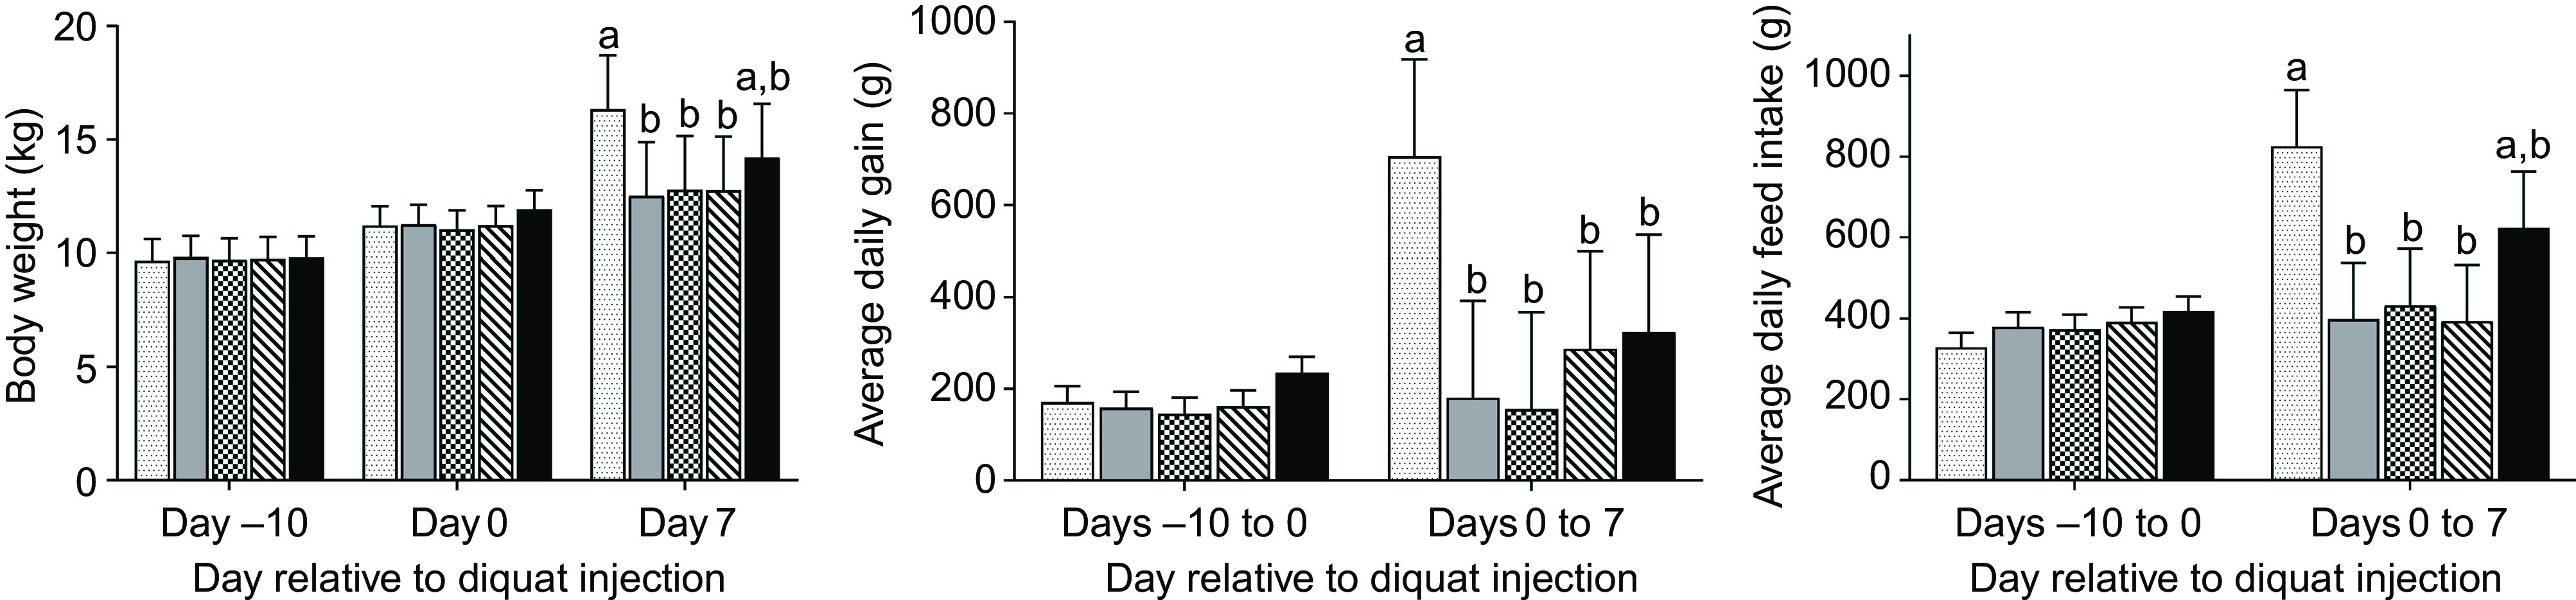
Growth performance and feed intake of piglets (n 7/treatment) in response to diquat challenge and dietary selenium supplementation. Values were presented as least square means with their standard errors. a,b Mean values with unlike letters were significantly different (P < 0·05). , Negative control without diquat challenge nor dietary selenium supplementation; , positive control with diquat challenge without dietary selenium supplementation; , sodium selenite group with diquat challenge; , soya protein-chelated selenium group with diquat challenge; , selenised yeast group with diquat challenge.